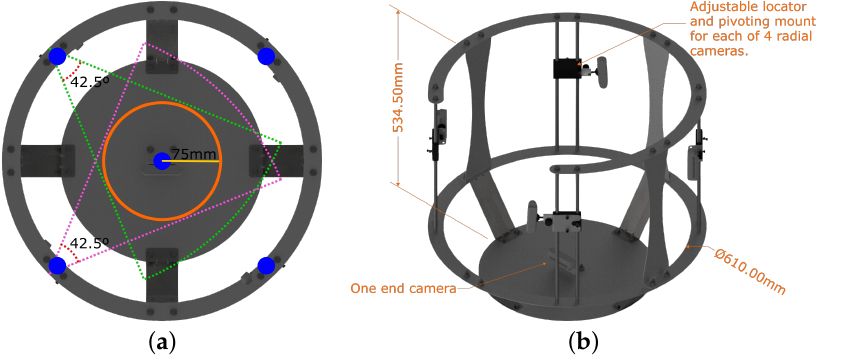
Figure 4. Mechanical design overview showing: ( a ) frame and camera setup with overlapping areas; ( b ) frame’s overall dimensions.